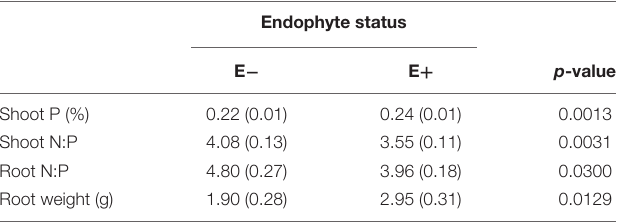
TABLE 3 | Main effect of endophyte status on nutrient characteristics and root biomass of tall fescue tissue.